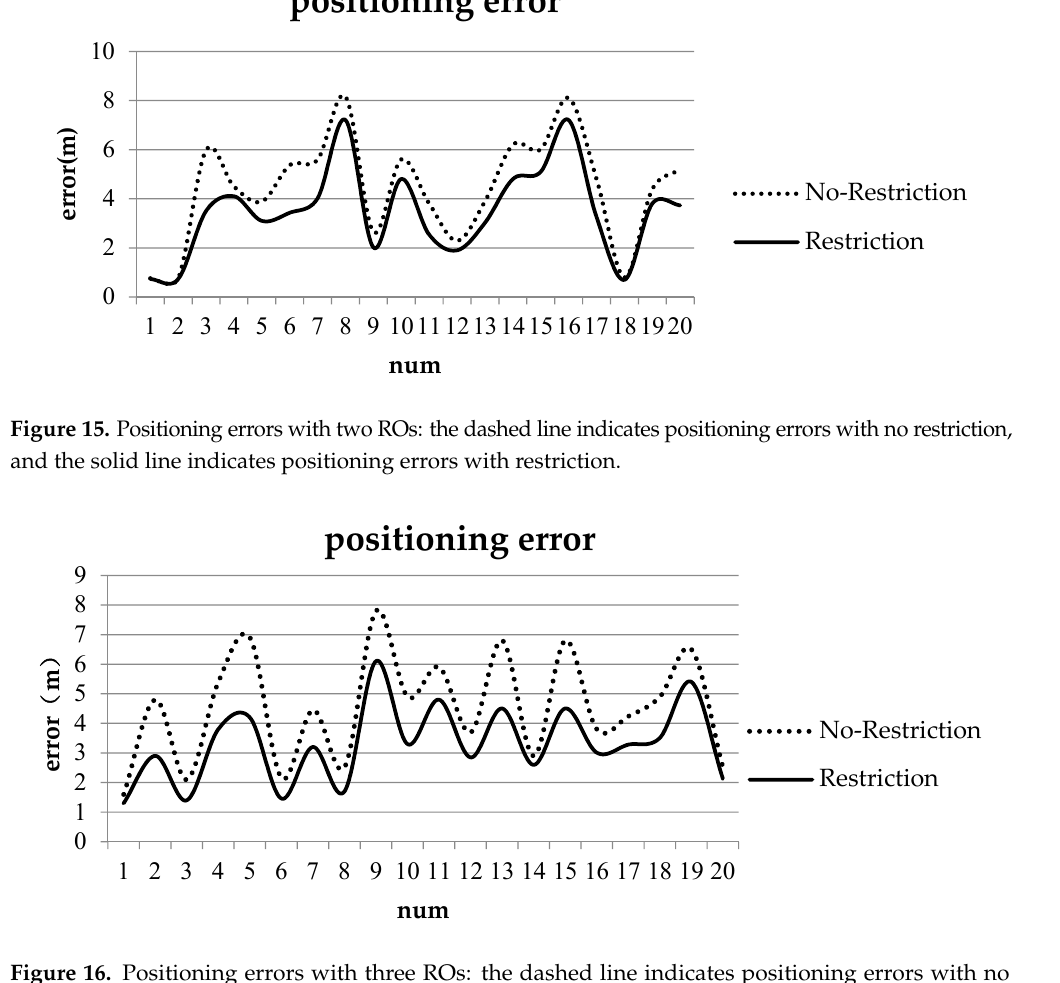
Figure 16. Positioning errors with three ROs: the dashed line indicates positioning errors with no restriction, and the solid line indicates positioning errors with restriction.